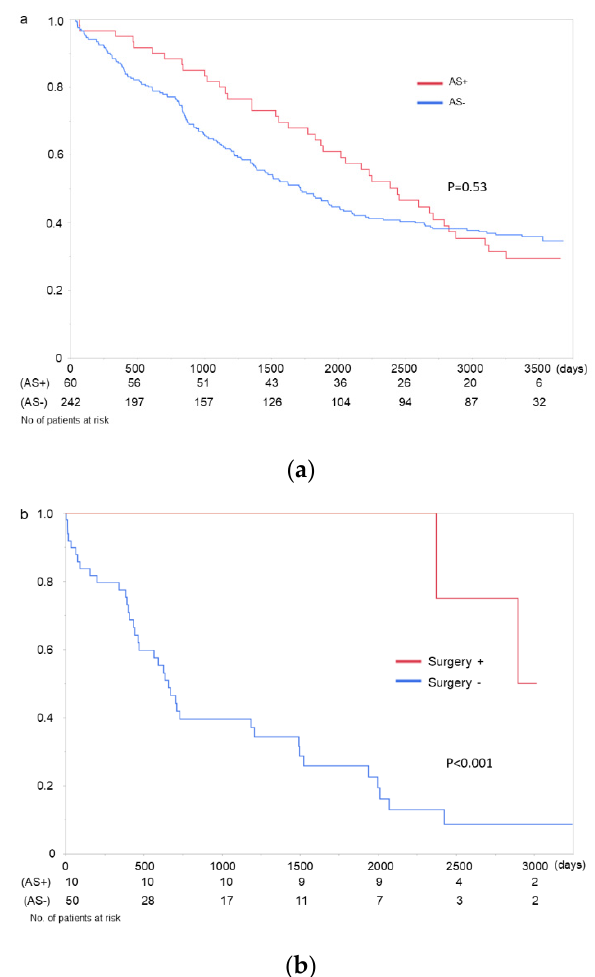
Figure 3. Kaplan–Meier survival analyses. ( a ) Patients who developed aortic stenosis during the follow-up period and those who did not. There were no significant differences between the two groups. The figures below the graph show the number of patients at risk of death according to the development of aortic stenosis. AS +: patients who developed aortic stenosis; AS-: patients who did not develop aortic stenosis. ( b ) Survival analysis from the first diagnosis of aortic stenosis. Patients who underwent aortic valve replacement showed a better outcome than those who did not, including those with mild aortic stenosis. The figures below the graph show the number of patients at risk of death according to undergoing surgery. S+: patients undergoing surgery, S-: patients not undergoing surgery.